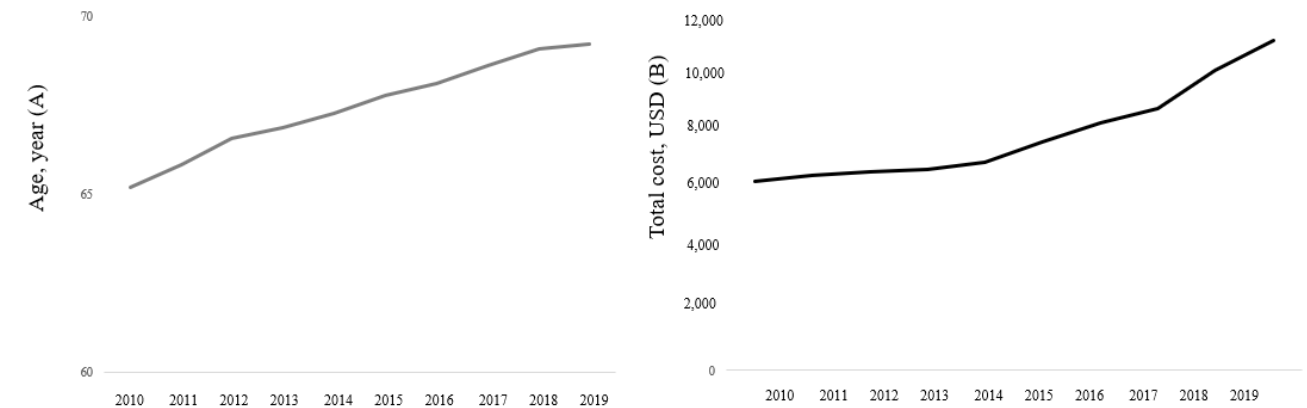
Figure 1. Trends of age ( A ) and total cost ( B ) of hospitalization among patients admitted to the ICU from 2010 to 2019. ICU, intensive care unit.